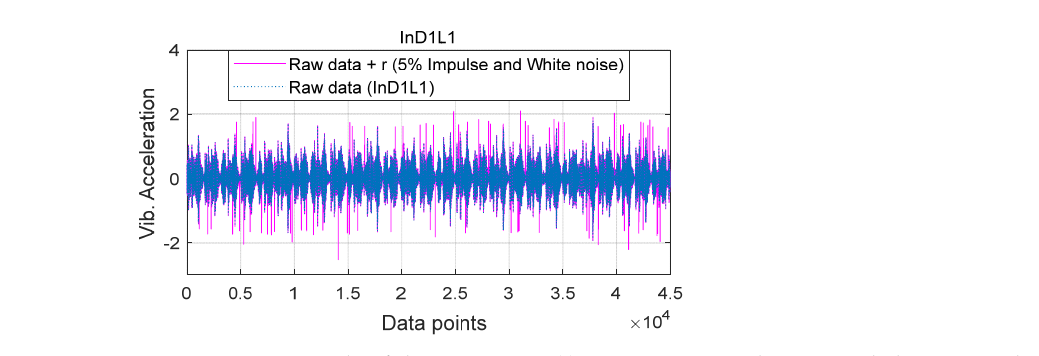
Figure 2. An example of the noise part r ( t ) participating in the InD1L1 belonging to the dataset ”Case 2” (see Table 2).